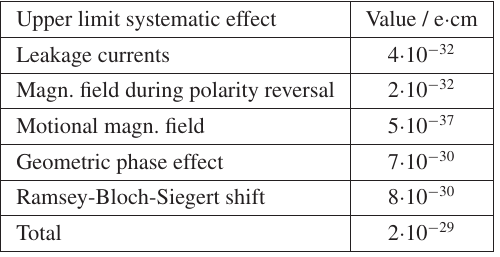
Table 1. Upper limit systematic effects.